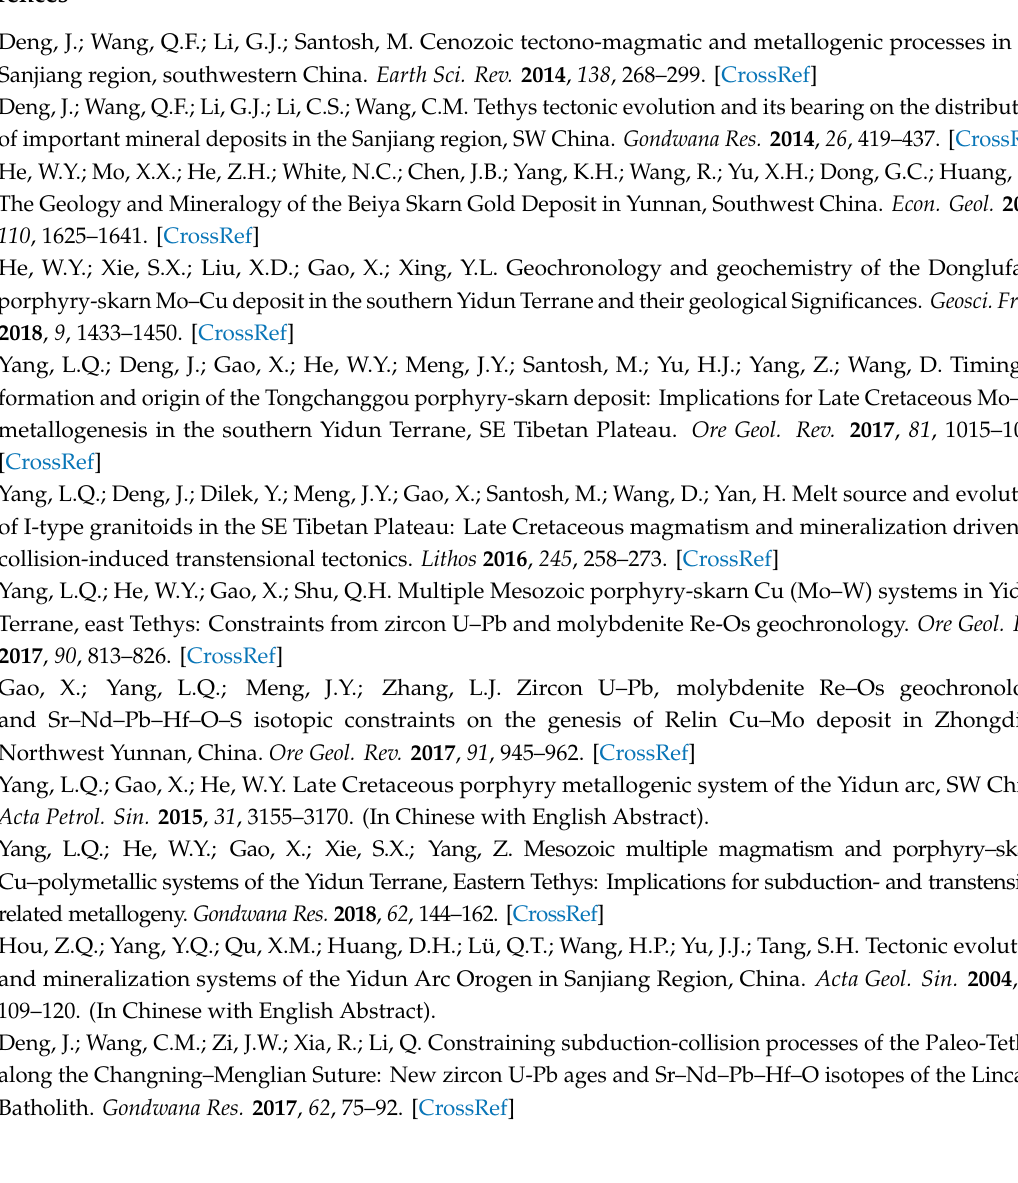
Table S1: LA-ICP-MS zircon U–Pb isotopic compositions of granodiorite and MMEs from the Daocheng batholith, Table S2: Zircon Lu–Hf isotopic compositions of granodiorite and MMEs from the Daocheng batholith, Table S3: LA-ICP-MS zircon trace element compositions (ppm) of granodiorite and MMEs from the Daocheng